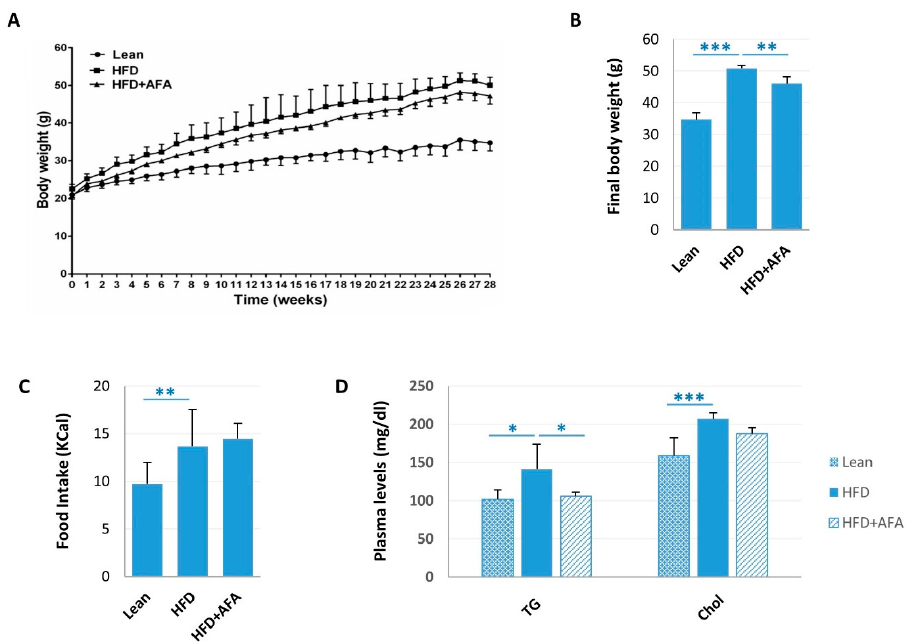
Figure 1. Effects of AFA chronic ingestion on body weight, food intake, and plasma lipids in HFD mice. ( A ) Body weight changes. ( B ) Final body weight. ( C ) Food intake. ( D ) Triglyceride (TG) and total cholesterol plasma (Chol) levels. Data are mean values ± S.E.M. ( n = 8 mice/group). * p < 0.05, ** p < 0.01, *** p < 0.001 vs. STD mice and vs. HFD-fed mice.